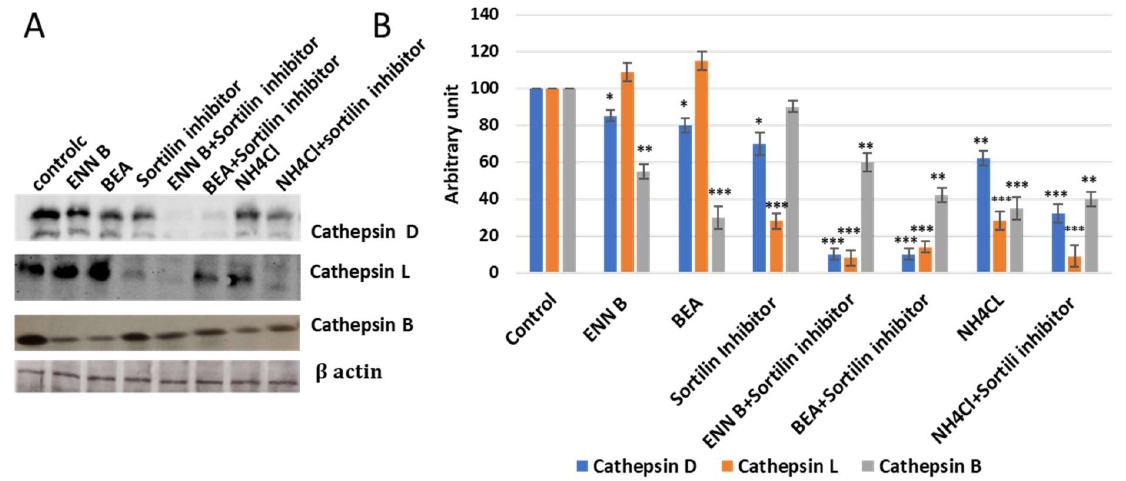
Figure 11. Effect of ENN B, BEA, and lysosomal receptors inhibitors on cellular retention of some lysosomal cathepsins. ( A ) Immunoblot detection of cathepsin D, cathepsin L, and cathepsin B secretion after treatment with ENN B, BEA, sortilin inhibitor, ENN B + sortilin combination, and BEA + sortilin combination. ( B ) Evaluation of cathepsin B, cathepsin D and cathepsin L secretion after treatment with ENN B, BEA, sortilin inhibitor, ENN B + sortilin combination, and BEA + sortilin combination. The data were analyzed using two-way ANOVA with Dunnett’s post hoc analysis (* p < 0.05; ** p < 0.01; *** p < 0.001; N = 7). Statistics were calculated using GraphPad Prism.